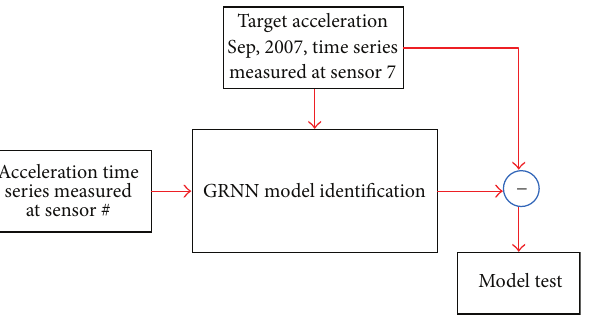
Figure 5: Damage detection GRNN model diagram.